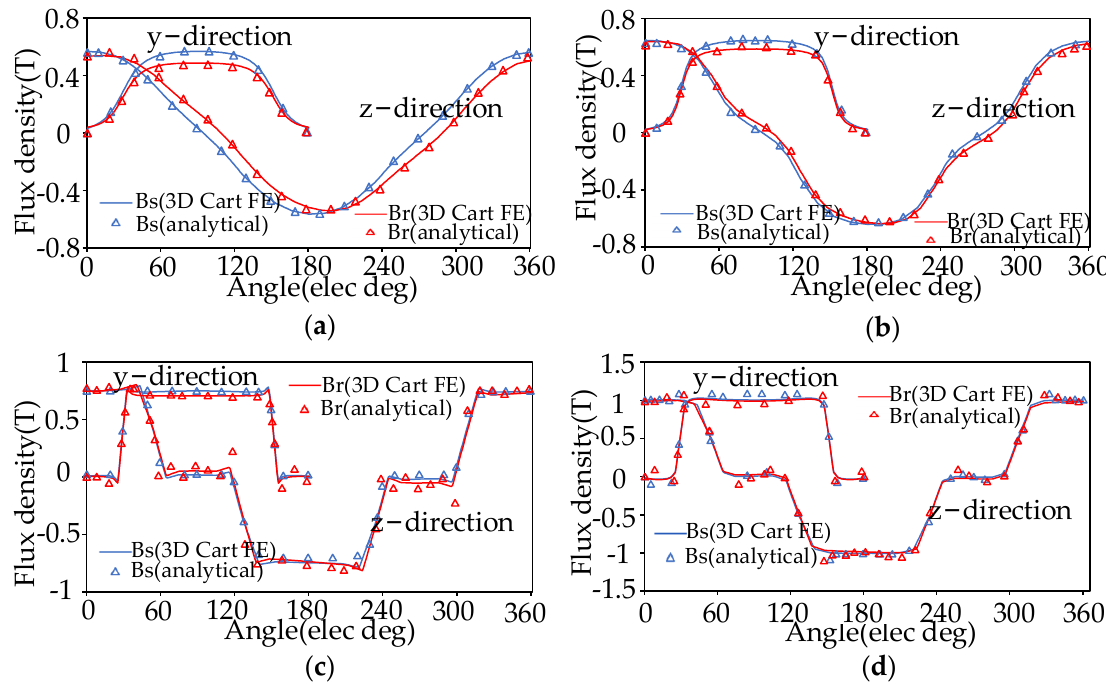
Figure 6. Flux densities in ( a ) region IV, ( b ) region III, ( c ) region II, and ( d ) region I of the 500 kW ECC with a two-segment Halbach magnet array.